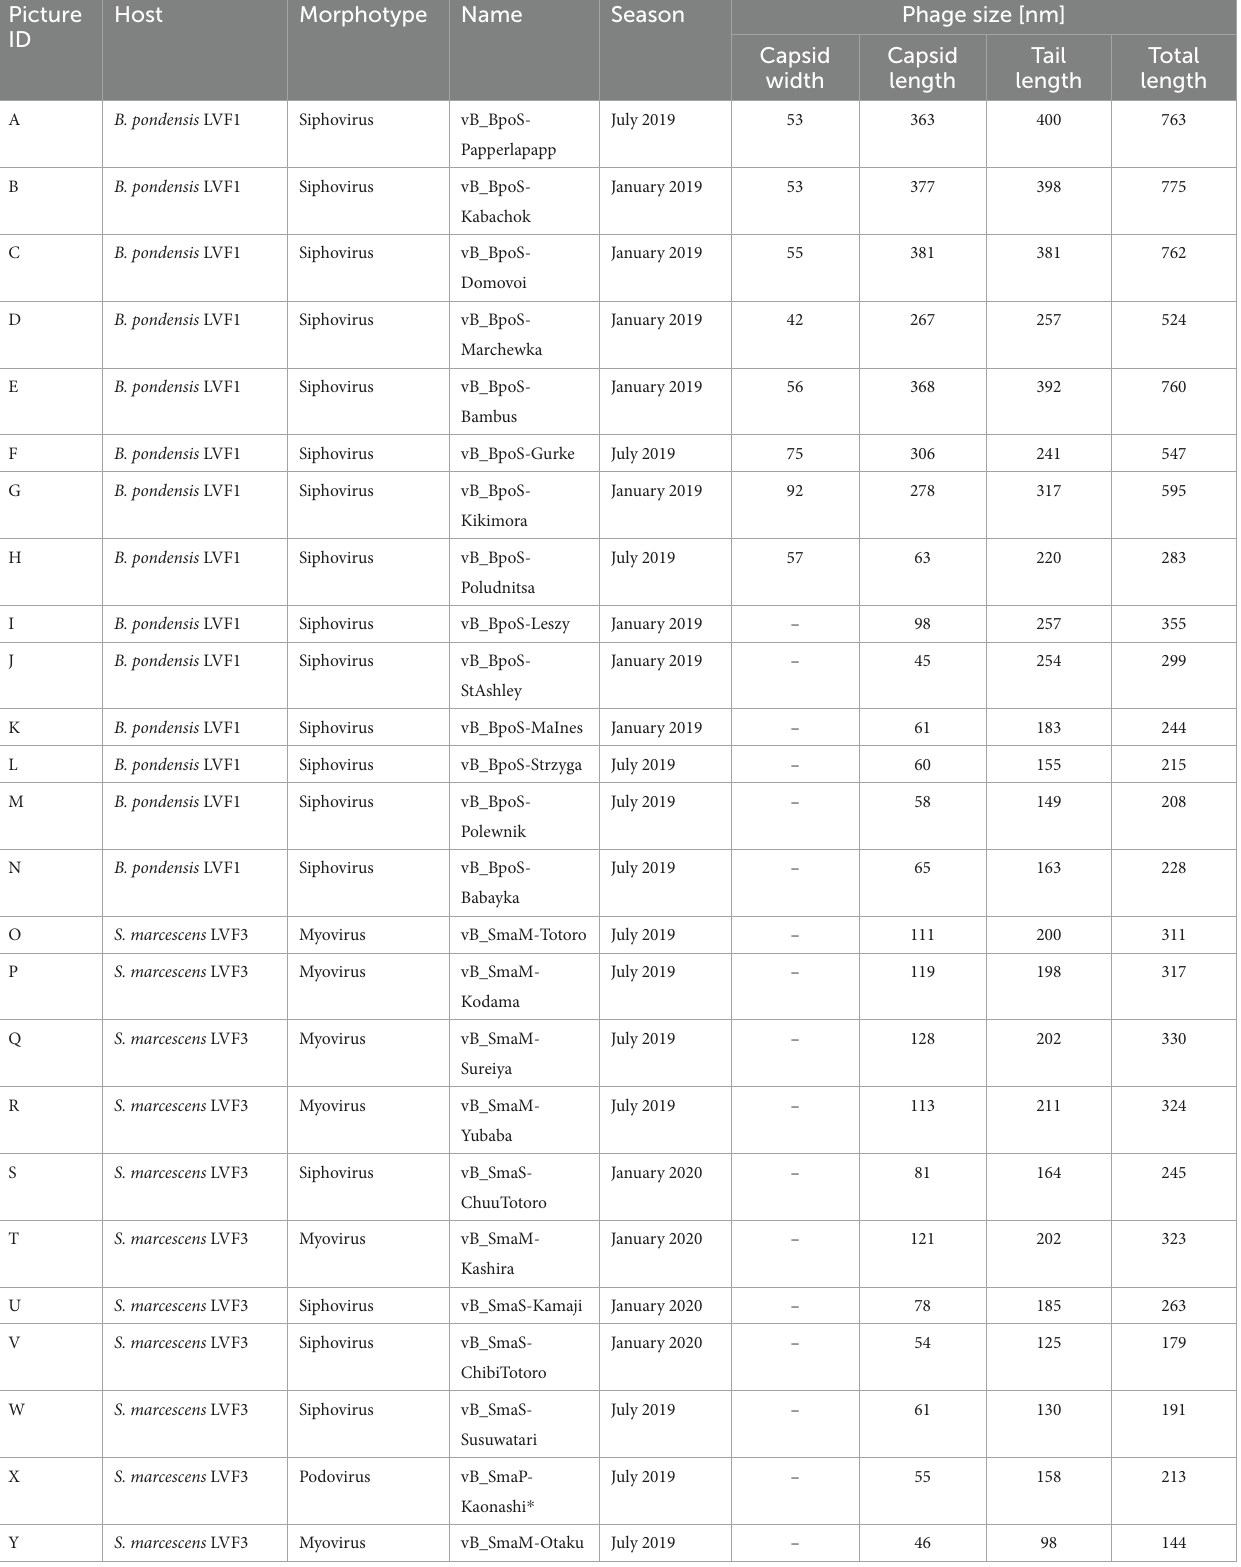
TABLE 1 Morphological properties of all bacteriophage isolates associated with B. pondensis and S. marcescens . Picture